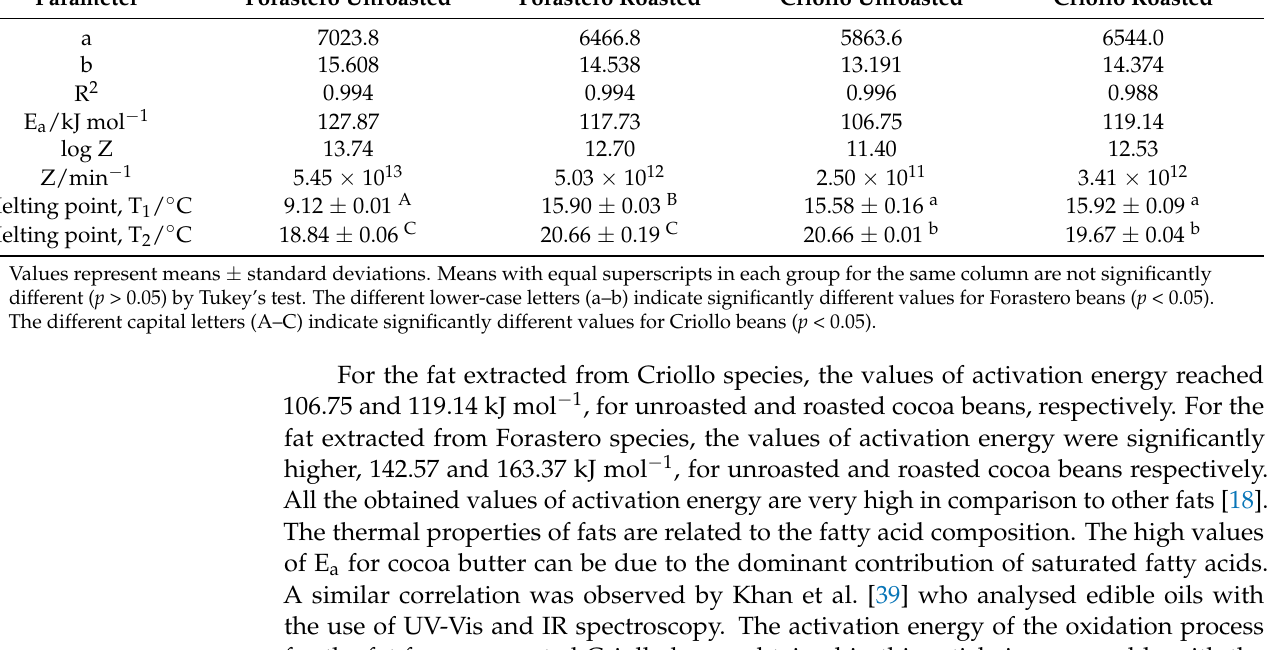
Table 4. Regression analysis of the DSC data, activation energies (E a ), pre-exponential factors (Z) and melting points ( ◦ C). Parameter Forastero Unroasted Forastero Roasted Criollo Unroasted Criollo Roasted